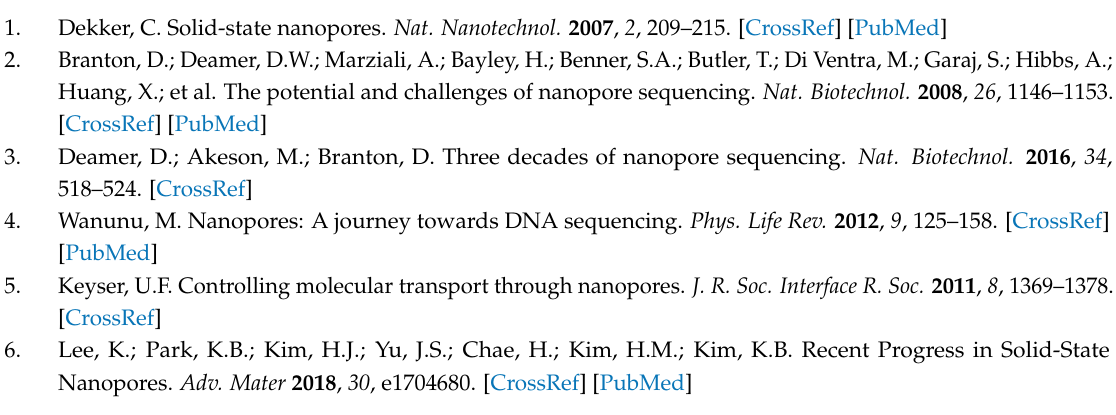
Figure S1: FEM based numerical simulation, Figure S2: Translocation and Clog of DNA, Video S1: Releases of T4 DNA, Video S2: Recapture of released T4 DNA, Video S3, S4 U turn of circular DNA of 10 kbp (S3) and phi X174 (S4), Video S5 lambda DNA translocate and Video S6 lambda DNA clog. Table S1: Physical properties of